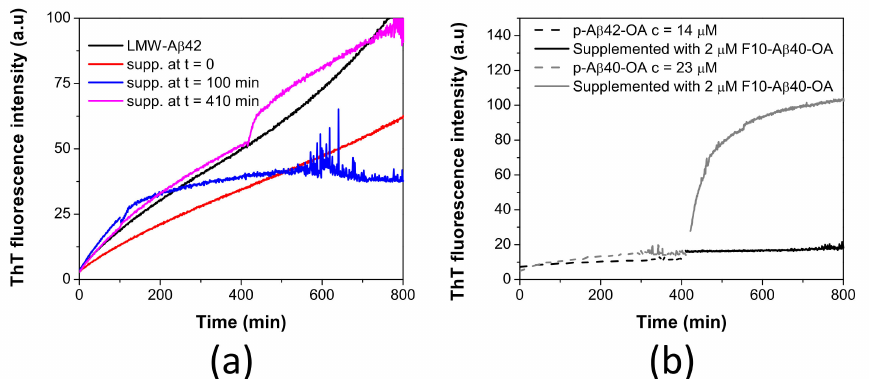
Figure 7. ( a ) Time dependence effect of the supplementation with F10-A β 42-OA on the aggrega- tion kinetics of LMW-A β 42 at c = 40 µ M (black line) followed by ThT fluorescence. LMW sam- ples were incubated at 37 ◦ C and supplemented with 1.8 µ M of F10-A β 42-OA at t = 0 (red line), t = 100 min (blue line), and t = 410 min (magenta line). ( b ) Comparison of the effect of F10-A β 40-OA on p-A β 40-OA (grey lines) and p-A β 42-OA (black